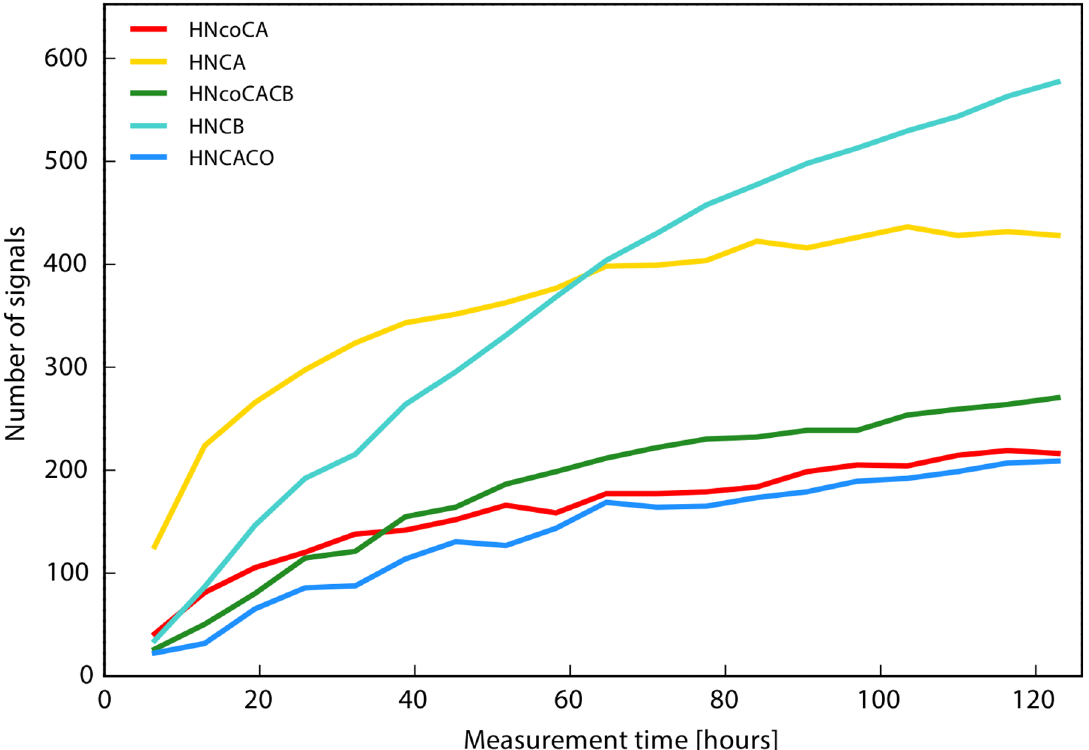
Fig 2. Peak appearance progress during the course of the TA procedure for the MALT1 sample. The horizontal axis shows the total measurement time excluding the HNCO experiment, which was recorded prior to the TA. The spectral processing and analysis was done automatically during the course of the data